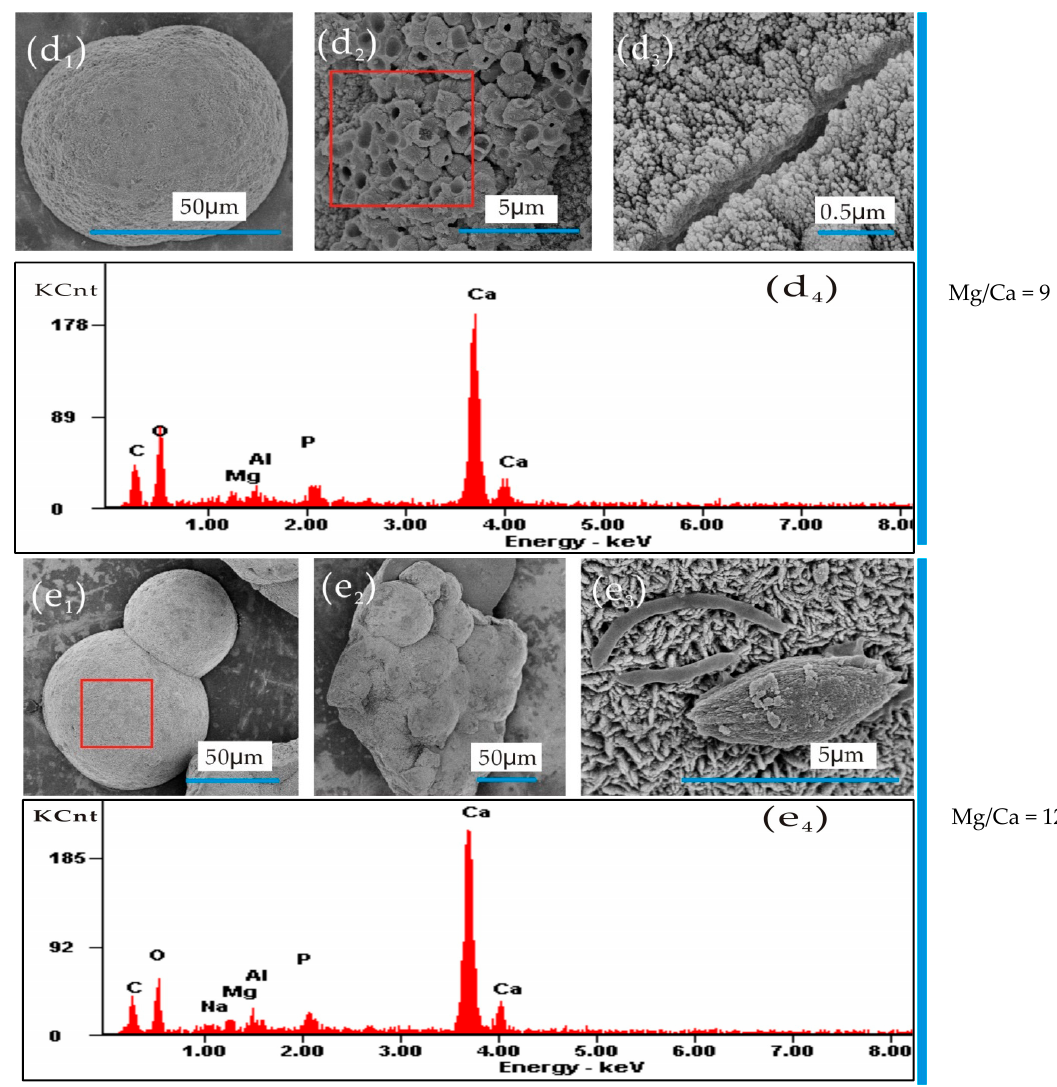
Figure 5. Scanning electron microscopy (SEM) and energy dispersive spectrometer (EDS) images of mineral precipitates cultured for 14 days.